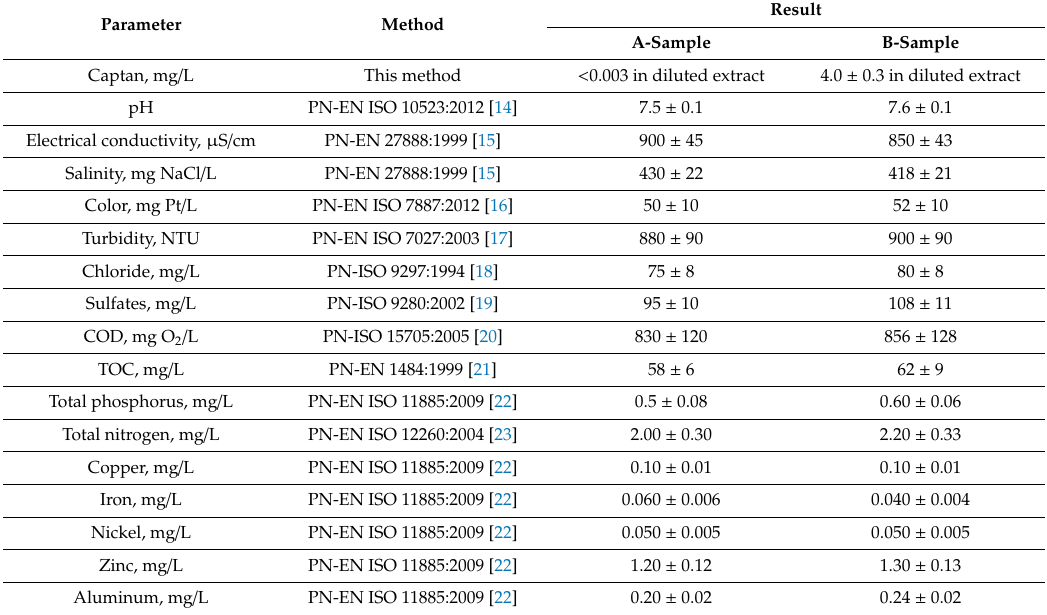
Table 1. Selected physicochemical parameters of real wastewater that originated from a plant protection products